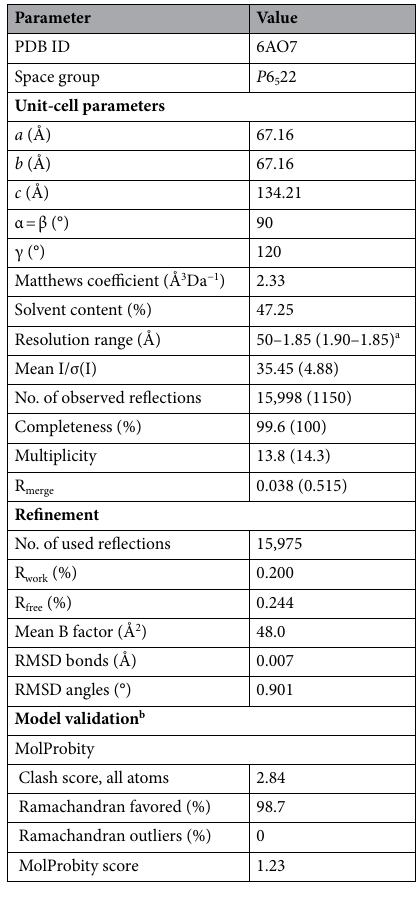
Table 1. Data collection, refinement and structure quality. a Value in parenthesis are statistics for the highest resolution shell. b Values calculated using